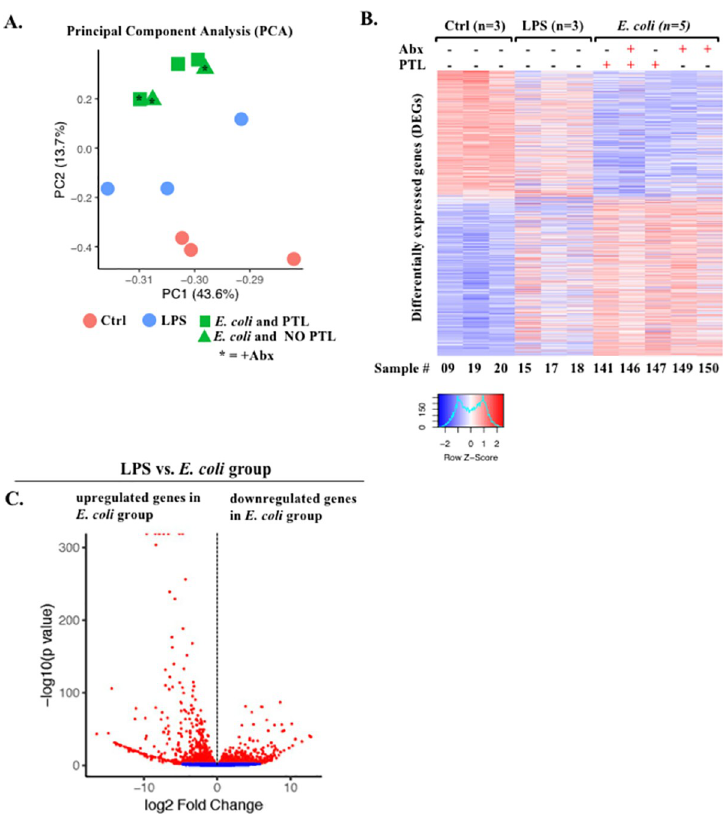
Fig 6. Comparative transcriptomics in chorioamnion-decidua between IA LPS and E . coli exposure. (A) PCA of RNA-seq data from chorioamnion-decidua tissue showing different segregation of transcriptomic profile based on exposures. (B) Heatmap of genes that are differentially expressed in chorioamnion-decidua cells upon different treatments showing the minimal interanimal variability within each group. (C) Volcano plot displaying DEGs from E . coli animals compared with LPS animals. Red dots indicate genes with FDR adjusted p -value < 0.05. Abx, antibiotics; DEG, differentially expressed gene; FDR, false discovery rate; IA, intra-amniotic; LPS, lipopolysaccharide; PCA, principal component analysis; PTL, preterm labor; RNA-seq, RNA